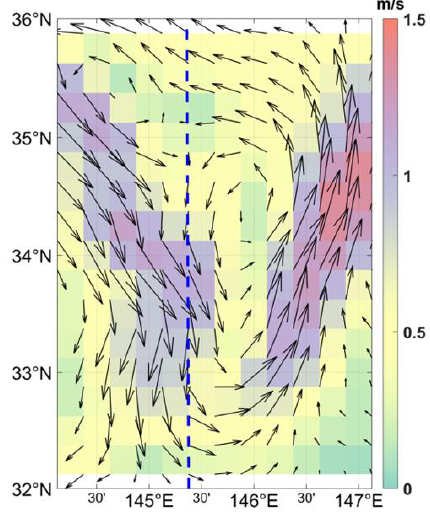
Figure 2. Velocities of a curved path derived from altimeters in the Kuroshio Extension region on 12 August 1998. Velocity vectors along the blue dashed line are tested by the convergence scheme of the iterative algorithm.